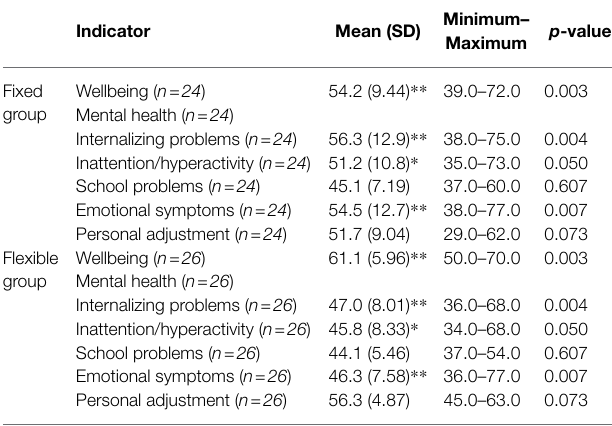
TABLE 6 | Mental health indicator results by group (fixed and flexible) for boys. Indicator